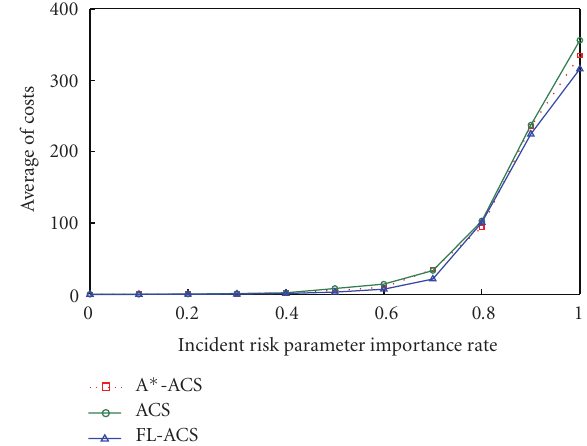
Figure 14: Average of 10 randomly selected O/D pairs cost averages for di ff erent “Distance” parameter importance rates. A comparison between performance of ACS, A ∗ -ACS, and FLACS algorithms is presented.